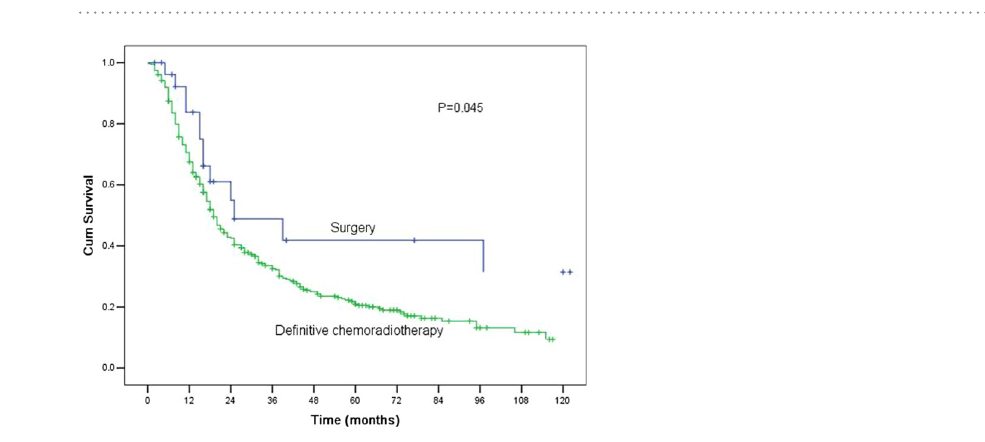
Figure 1. Comparison of the survival curves for patients with cervical oesophageal cancer who underwent salvage surgery and non-salvage surgery. The MST and 5-year OS rate for patients who underwent salvage surgery were 15.0 months (95% CI 10.5–19.5) and 0%, respectively, which were significantly lower than those of 97.0 months (95% CI 0.1–193.9) and 54.0%, respectively, for patients who underwent non-salvage surgery (P = 0.007).